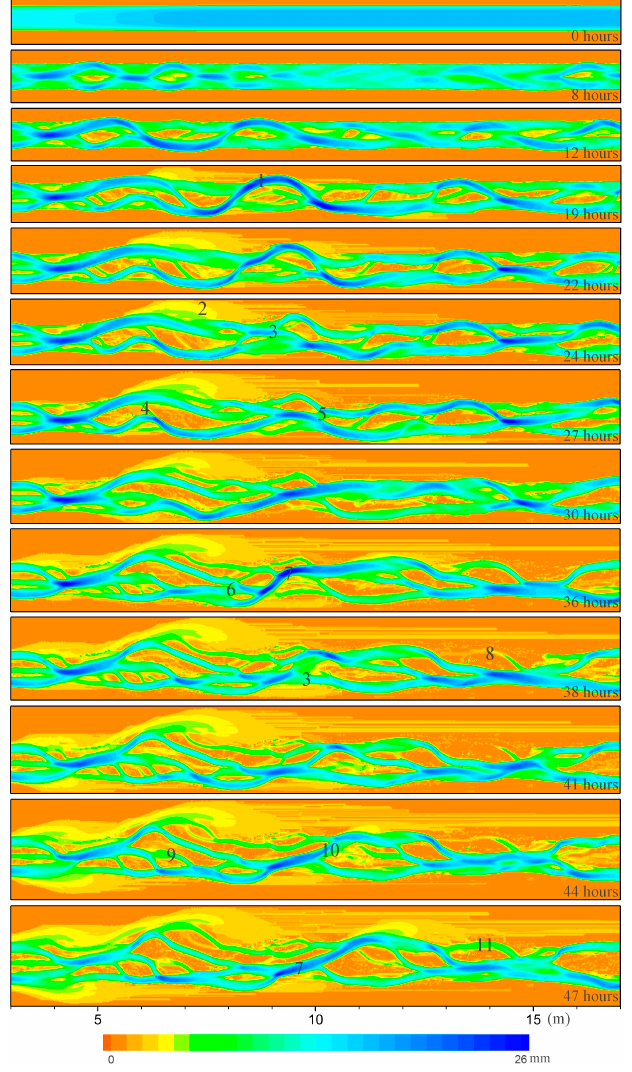
Figure 4. Morphologic changes and activities during the evolution process of the model predicted river (water depth/mm). 1: increasing sinuosity of the main channel; 2: the generation and obliteration of pseudo-anabranches; 3: avulsion by incision; 4: abandonment of the secondary channel; 5: reconnecting of two active channels; 6: avulsion by overflow; 7: concentration of the flow in the main channel; 8: avulsion by progradation; 9: water diversion from one secondary channel to an existing or new channel; 10: shifting of the main channel; and 11: regeneration of an abandoned channel.